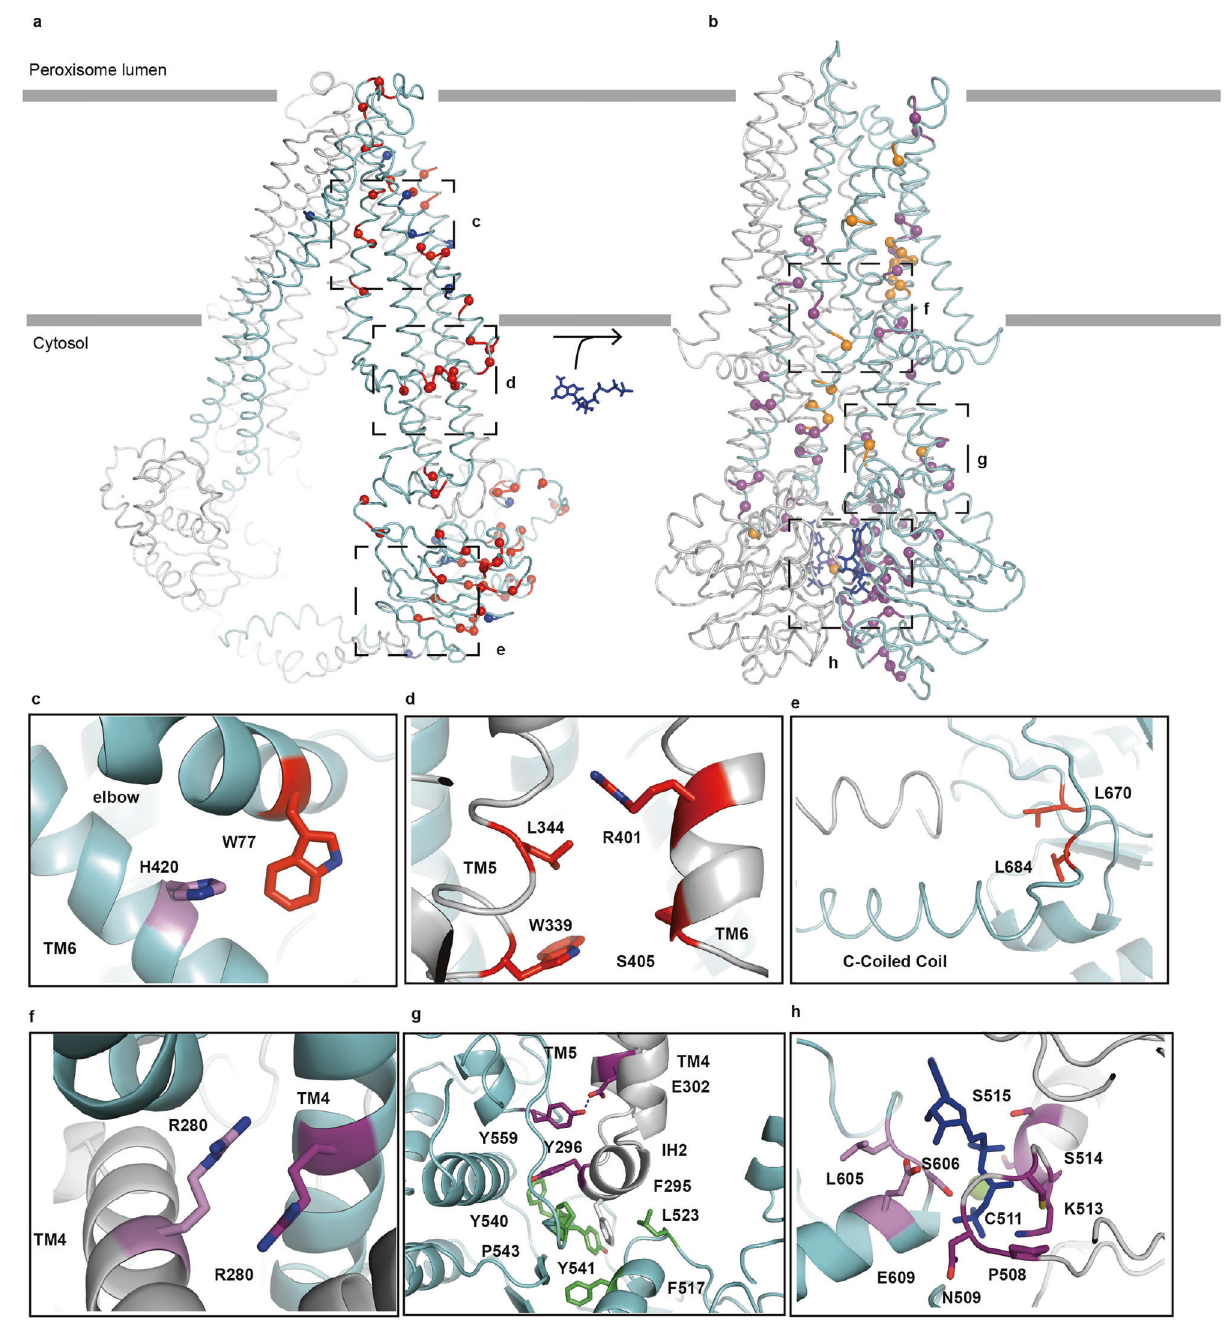
Fig. 6 Mapping of the locations of disease-causing mutations by using the inward-facing and outward-facing structures of ABCD1. a Red balls represent the deleterious mutations causing the reduced expression of ABCD1 in human tissues; they were selected because they mostly form interactions in the inward-facing structure. Blue balls indicate the mutations that cause no effect on the level of proteins in human tissues but result in normal expression levels of proteins with functional defects. b Location of mutations on the structure of ABCD1 in outward-facing state. Purple balls represent the deleterious mutants, and orange balls indicate the mutations that affect the function of ABCD1 but cause no folding problem. c – h Roles of representative residues by 3D structural analysis affect the interaction of the NBD of one subunit with the IH2 of protein in an outward-facing conformation. 32,41 Further structural the other one. studies of R280C are needed to clarify its in fl uence on the function In summary, a series of conformations of ABCD1 from the of the protein. Many cases have been reported for the S606 and inward-facing state 1 was presented for the binding of substrates G512 positions from signature and Walker A motifs, respec- to the outward-facing state for substrate release (Fig. 6 and Movie tively, 40,42,43 which interact with ATP molecules in the outward- S1). The substrate and ATP increased the activity of ABCD1 facing conformation (Fig. 6h). A large number of mutations through TMDs and NBDs. The C-terminal coiled coil, a unique occurred at the ATP-binding site, which may affect the activity of feature of ABCD1, regulated the activity of the protein by direct ABCD1. Lastly, the pathogenic mutation of Y559 (Fig. 6g) 26 may Signal Transduction and Targeted Therapy (2023)